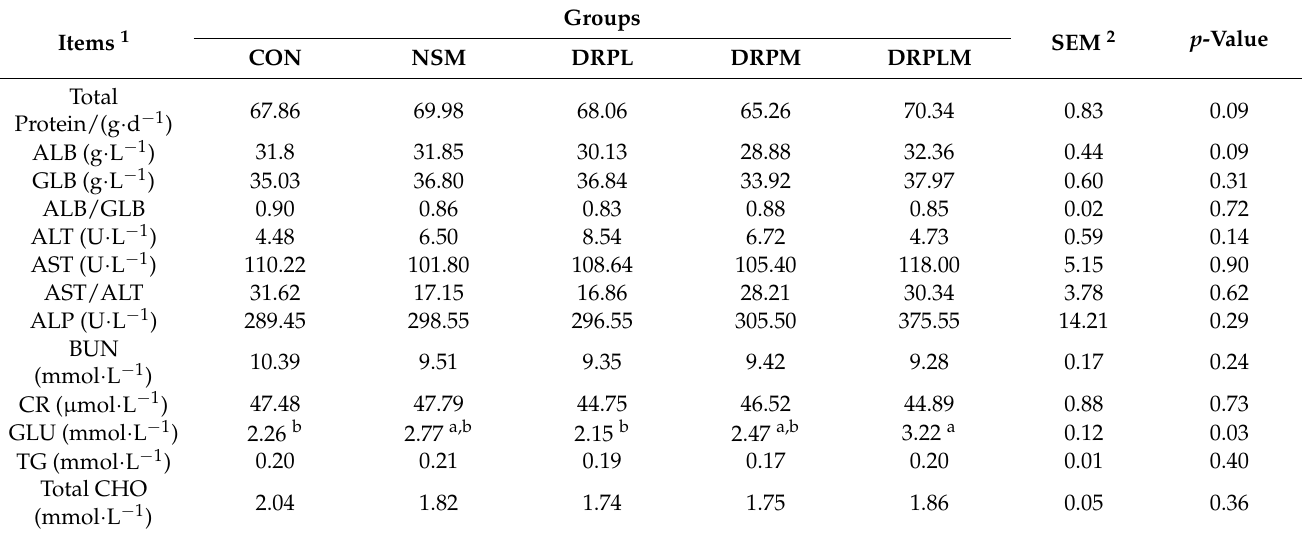
Table 7. Effects of dietary supplementation with rumen-protective amino acids on serum parameters in Hu